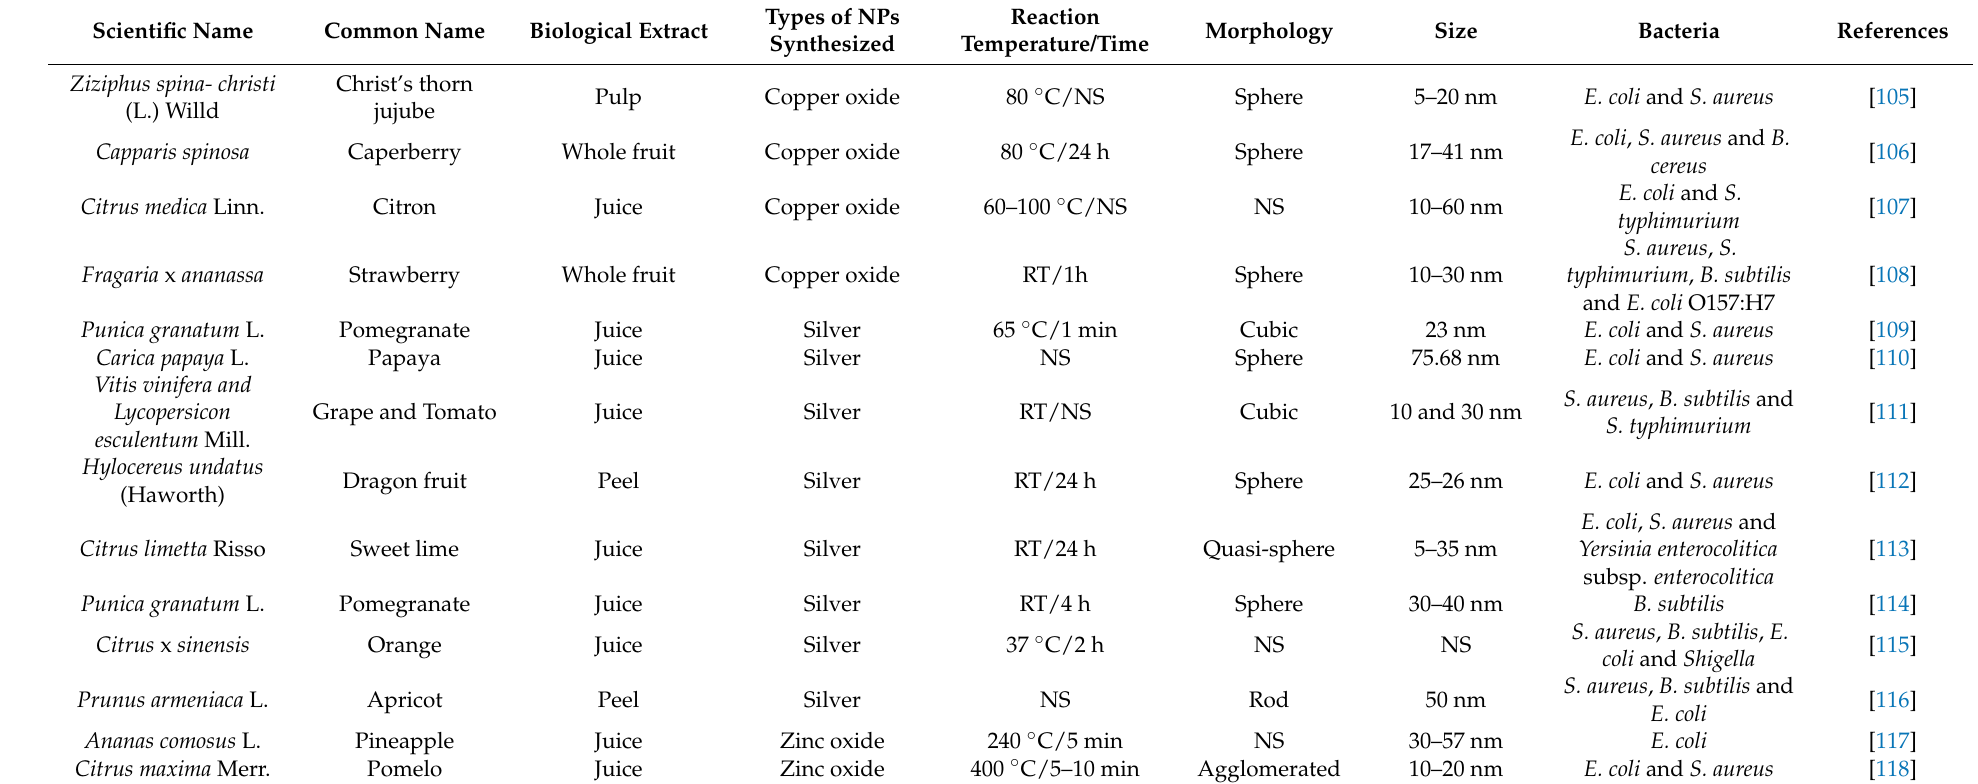
Table 5. Antibacterial activity of functionalized nanoparticles against foodborne